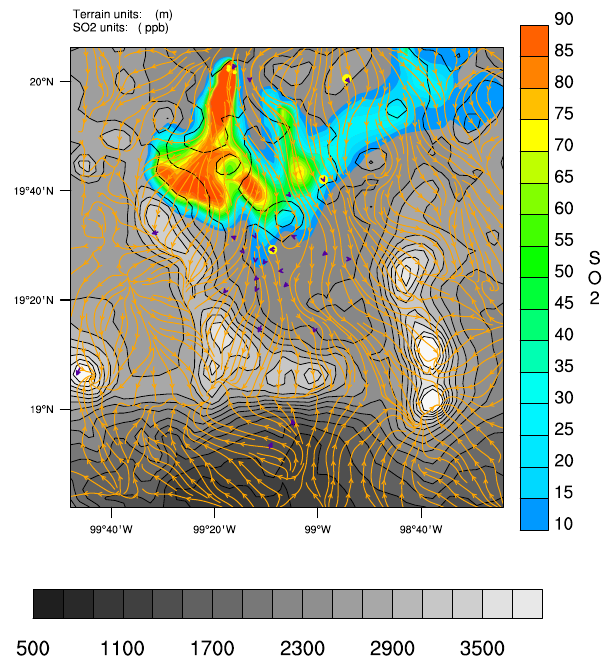
Figure 7. Wind flow tends to split the merged plume coming from Tula. The TIC plume is transported to the northwest of the basin; the Apaxco cement plant plume is transported to the northeast and can impinge T1 supersite. This plot corresponds to 23 March at 09:00LST. Purple arrows represent wind vectors of monitoring sta- tions. Yellow circles denote the location of the MILAGRO super-